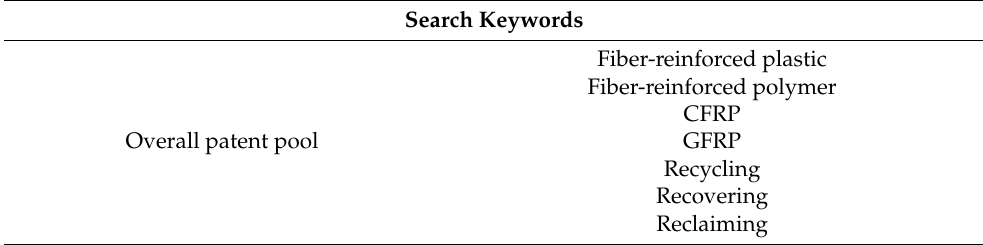
Table A1. Search keywords for identifying the overall patent pool. Search Keywords